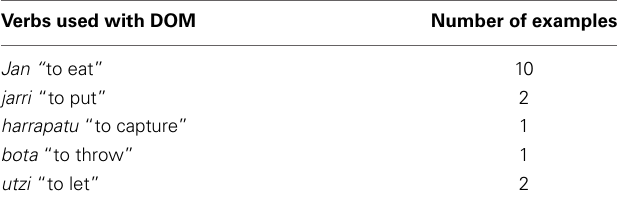
Table 9 | Use of DOM in spanish (bilingual